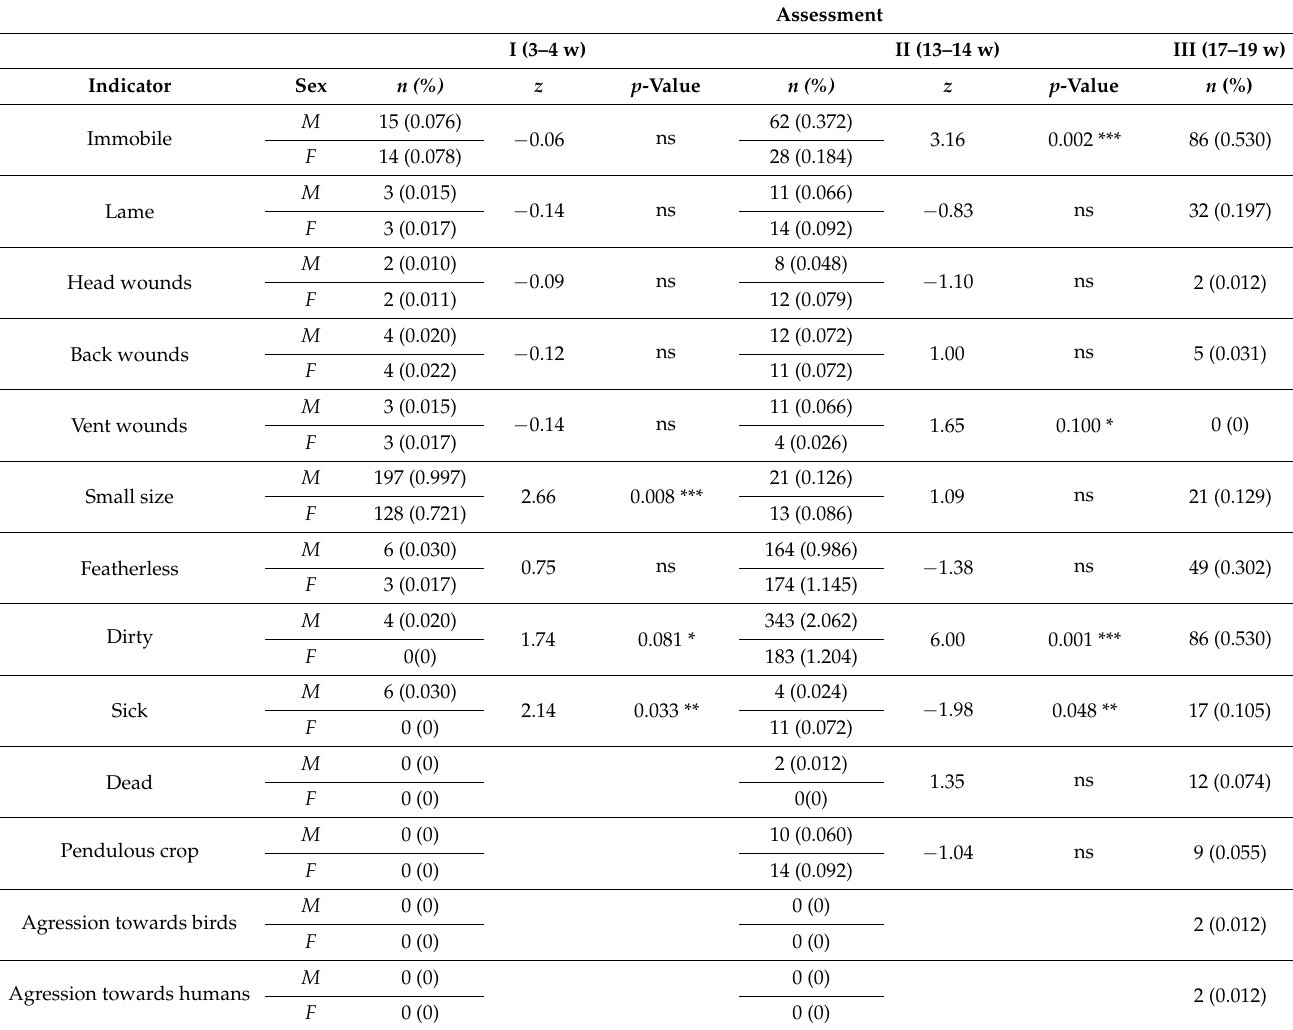
Table 4. Welfare indicator mean values for male and female turkeys expressed as percentage at each